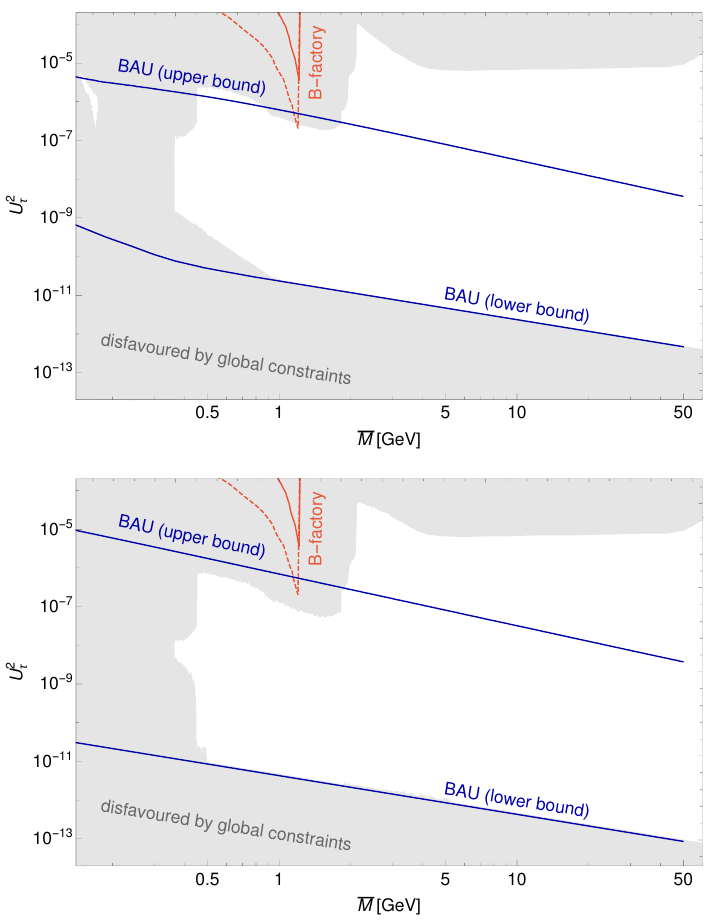
Figure 7 . Limits on U 2 as a function of (cid:22) M = ( M 1 + M 2 ) = 2 for normal hierarchy (top panel) and (cid:28) inverted hierarchy (bottom panel). The grey area corresponds to the parameter region that is dis- favoured by the combined constraints discussed in subsection 2.3. The dark blue lines are the upper and lower bound of U 2 consistent with neutrino oscillation data and the requirement to account (cid:28) for the observed BAU. The conservative (red, solid) and most optimistic (red, dashed) 95% c.l. limits on U 2 are shown for a kinematic analysis of 10 6 (cid:28) (cid:0) ! (cid:23)(cid:25) (cid:0) (cid:25) + (cid:25) (cid:0) decays at B-factories [176]. (cid:28) Further, U 2 can e.g. be probed by SHiP [166, 167], LBNE/DUNE [166, 167], FCC-ee (cid:28)